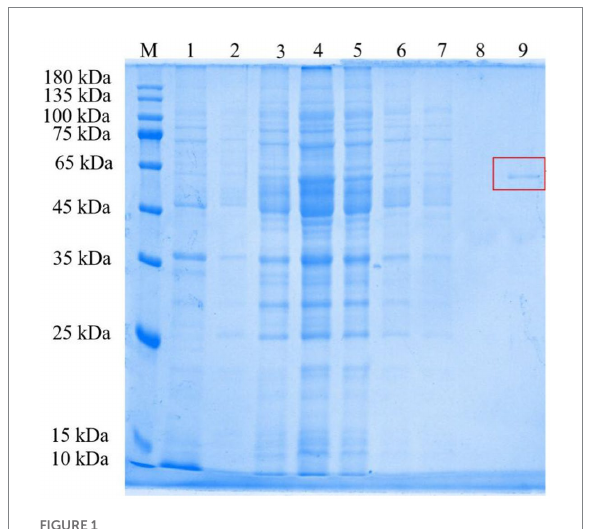
FIGURE 1 Representative gel of purification steps of RpfB protein from Rhodococcus sp. (GX12401). M, Protein molecular weight markers; 1, Escherichia coli BL21 cleavage protein containing pET30a (+); 2, Bacterial proteins before induction; 3, Insoluble body protein; 4, Soluble protein; 5, Unbound protein; 6, Protein eluted with buffer containing 20 mM imidazole; 7, Protein eluted with buffer containing 50 mM imidazole; 8, Protein eluted with buffer containing 80 mM imidazole; 9, Proteins were eluted with buffer containing 200 mM imidazole, and protein bands were marked with red boxes. The gel was stained with Coomassie Brilliant Blue